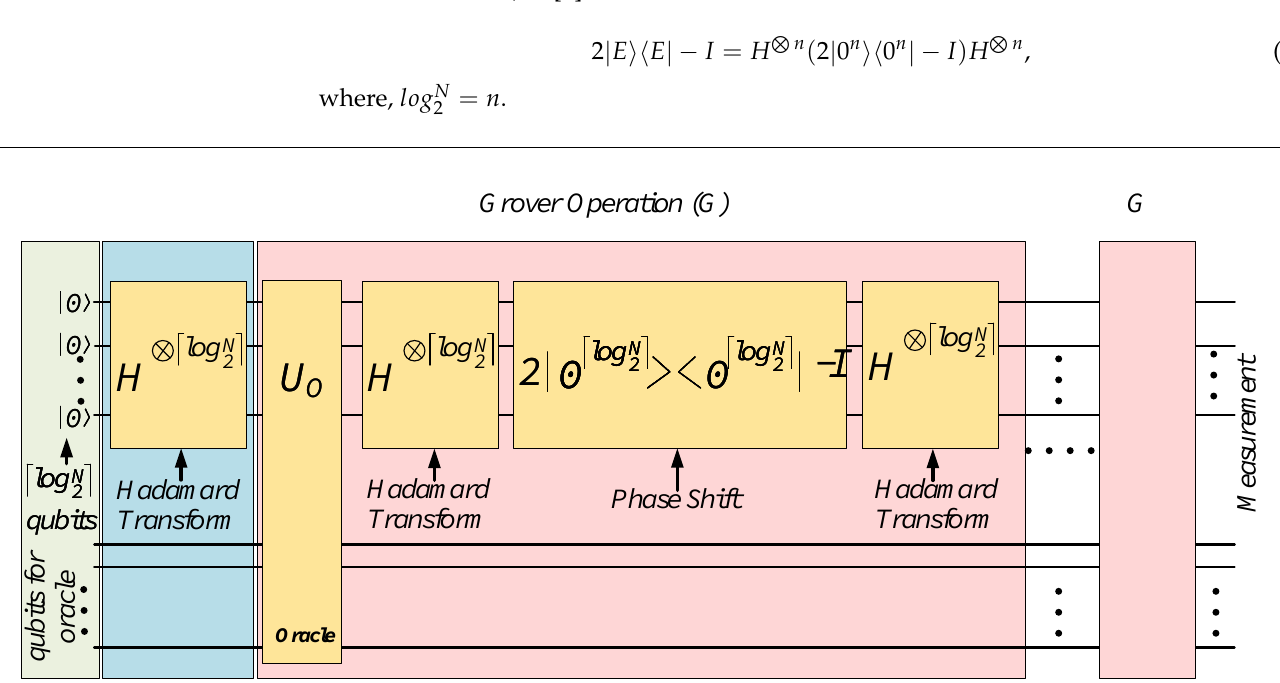
Figure 2. The quantum circuit of Grover’s algorithm (it is important to note that, if it is needed, some extra qubits can be used for the oracle), and detailed information can be found in